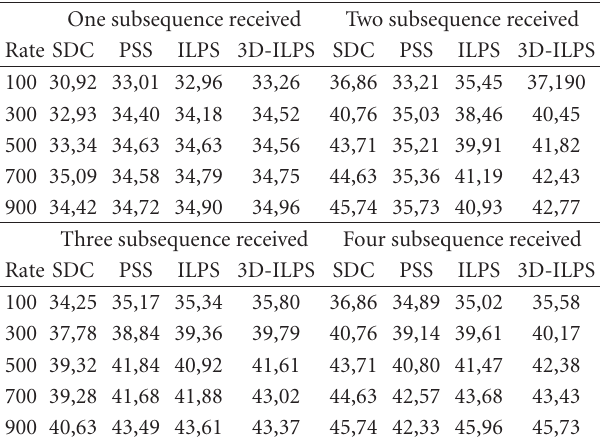
Table 4: Performance of depth view, Breakdance, 10% packet loss.